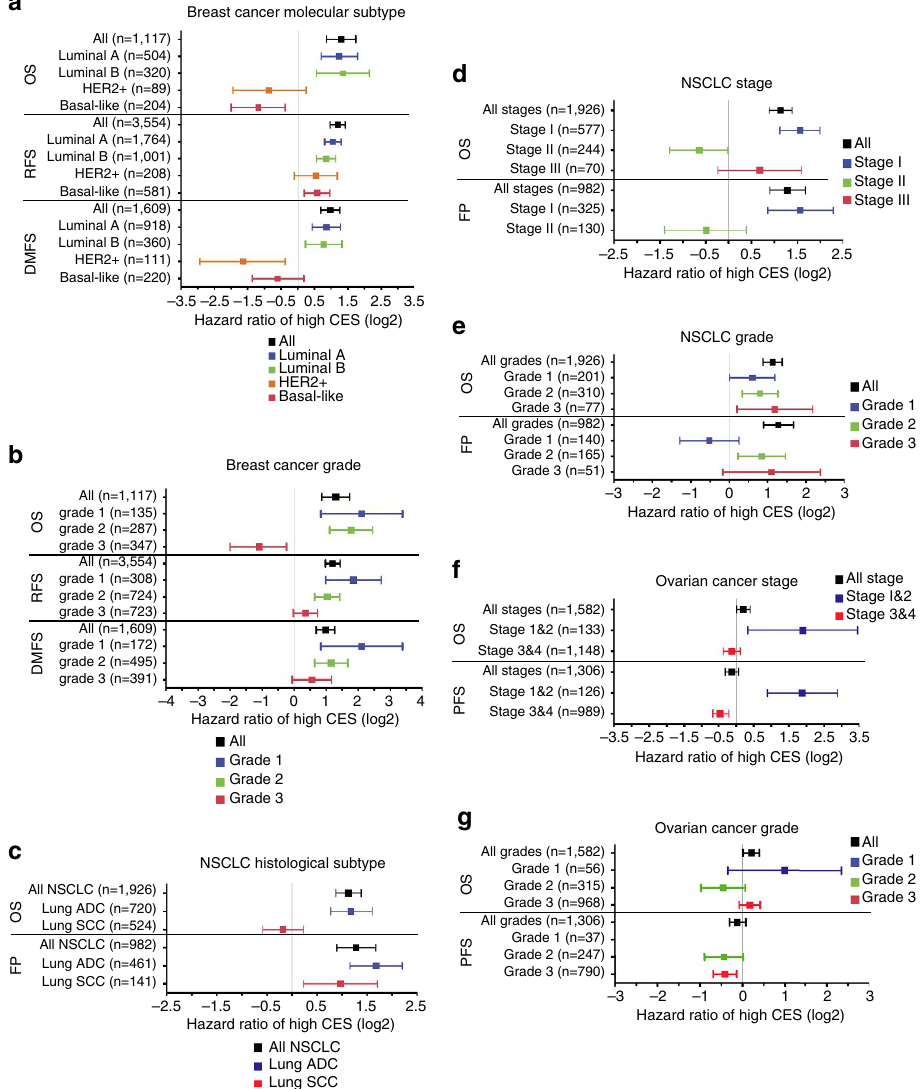
Figure 5 | CES signature is prognostic after patient stratification by common clinicopathological factors. CES threshold for high and low were automatically computed using K–M Plotter database. Squares and error bars in the plots denote log2 scales of hazard ratio (HR) and 95% confidence interval (CI), respectively. ( a ) Breast cancer molecular subtypes (see Supplementary Fig. 12 for individual Kaplan–Meier plots). ( b ) Breast cancer grades (Supplementary Fig. 14). ( c ) NSCLC histological subtypes (Supplementary Fig. 16). ( d ) NSCLC stages (Supplementary Fig. 17). ( e ) NSCLC grades (Supplementary Fig. 18). ( f ) Ovarian cancer stages (Supplementary Fig. 21). ( g ) Ovarian cancer grades (Supplementary Fig. 22).